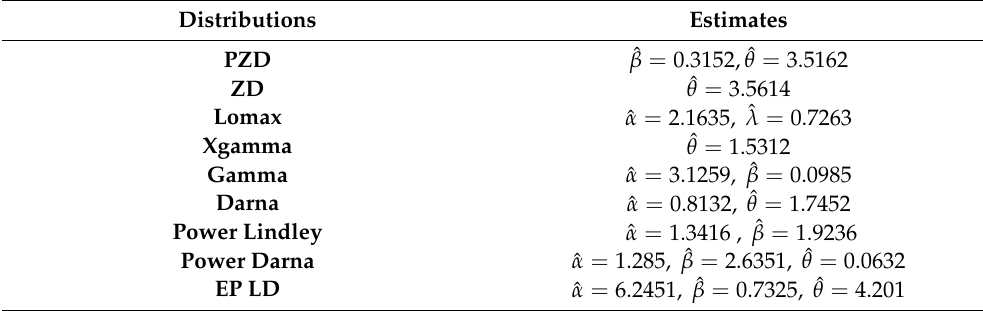
Table 11. ML parameter estimates for the alternative distributions with glass fiber data.